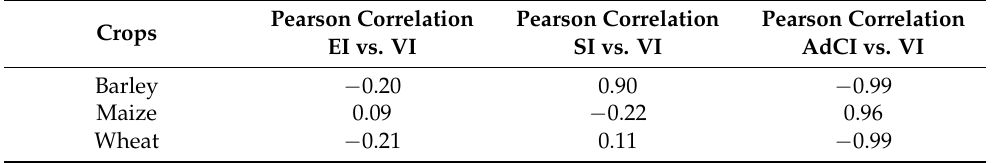
Table 1. Pearson Correlations between the Sensitivity (SI), Exposure (EI), Adaptive Capacity (AdCI) Indexes vs the Vulnerability Index (VI) at the National